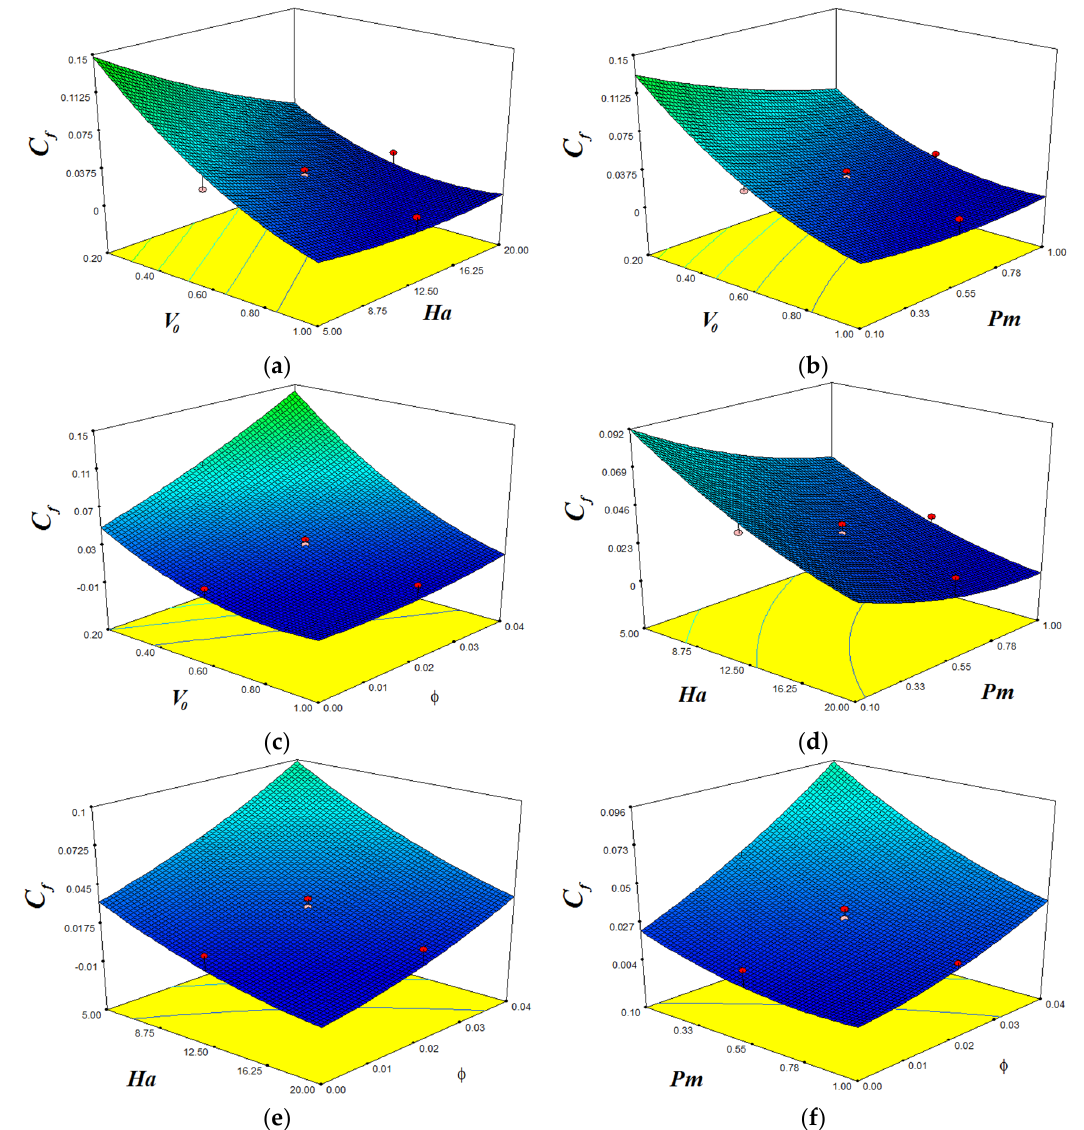
Figure 7. 3D surface plots for skin friction coefficient. ( a ) Pm = 0.55, φ = 0.02 ; ( b ) Ha = 12.5, φ =